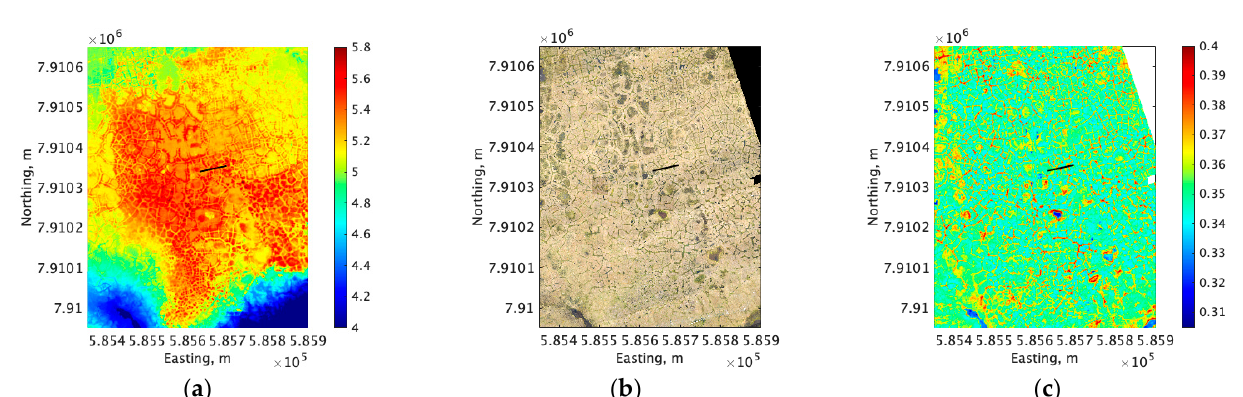
Figure 2. ( a ) High-resolution LiDAR digital elevation model (DEM) over the NGEE Arctic site (elevation in meters), ( b ) orthorectified airborne RGB image, and ( c ) greenness index (gI) computed from the RGB image. In the plots, the black line is the tram location. In ( a ), the same DEM was used as Hubbard et al. (2013) and Wainwright et al. (2015).